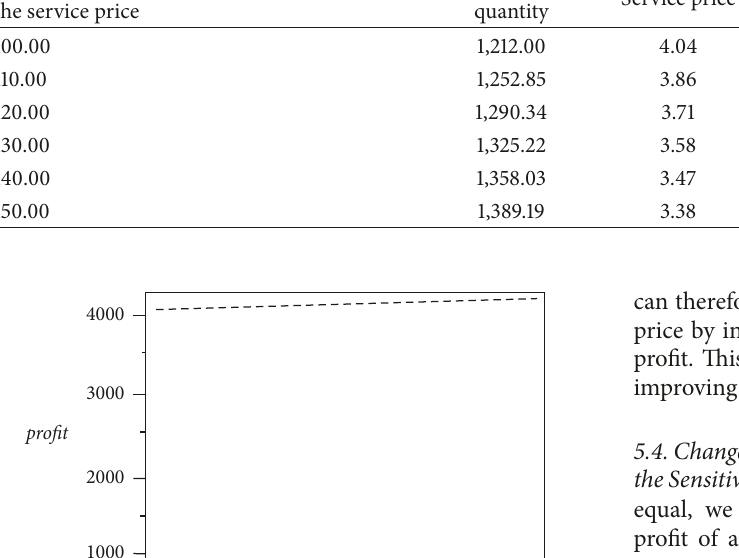
Table 4: The effect of the sensitivity coefficient of the order quantity to the logistics service price on the supply chain members’ decisions. Sensitivity coefficient of the order quantity to the service price